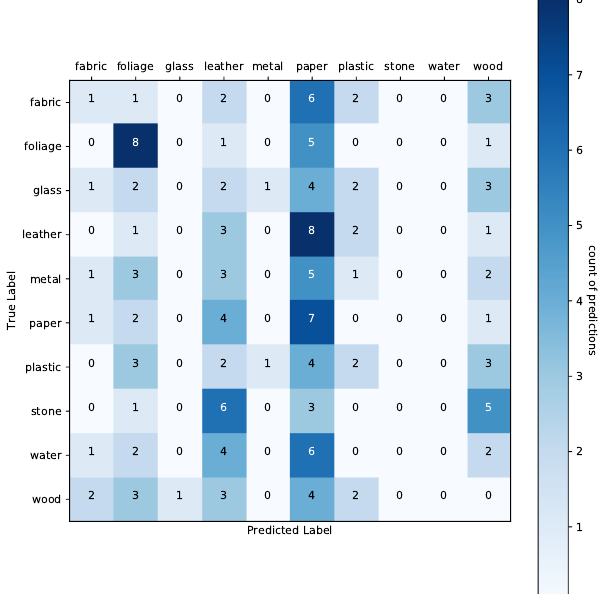
Figure A6. Experiment 1 with SGD Optimizer—The confusion matrix correlates with the best model (DWTdP) obtained for the FMD